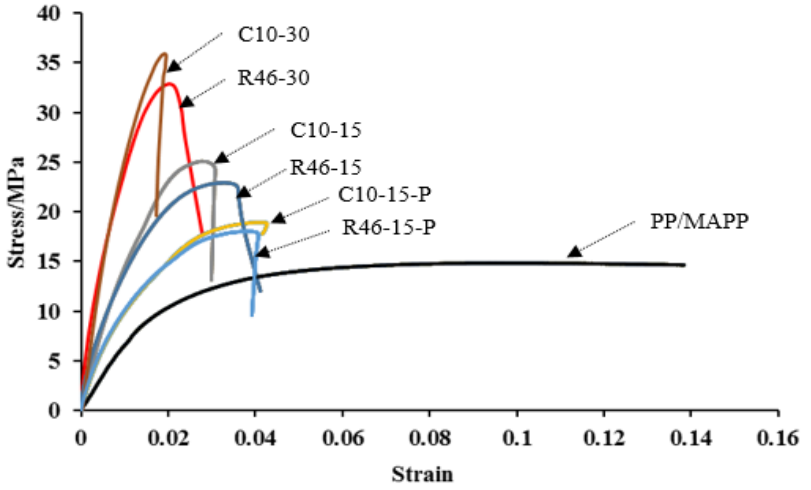
Figure 13. Typical stress–strain curves for PP/MAPP and composites reinforced with approximately 15 and 30 wt% fibre loaded parallel and perpendicular to main fibre alignment direction.